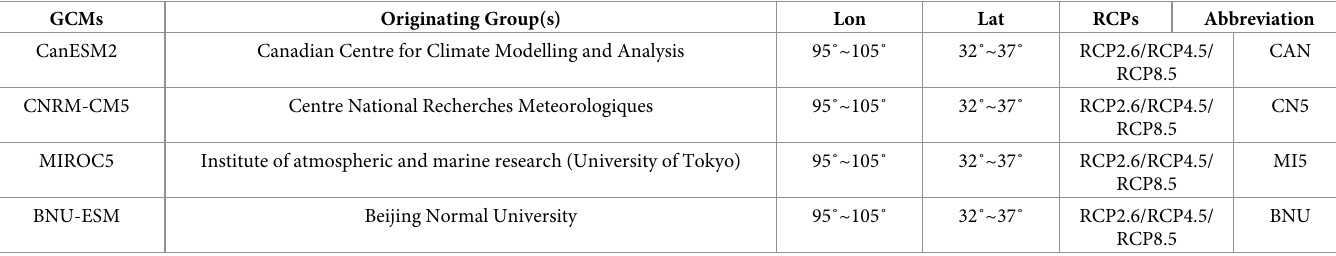
Table 1. GCM climate model selection and research area grid